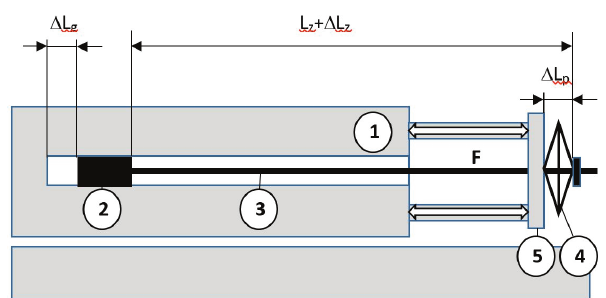
Fig. 15. Diagram showing model of the rock bolt installed and loaded at the test rig; 1 – concrete block; 2 – bolt head; 3 – bolt rod; 4 – deformable component; 5 –